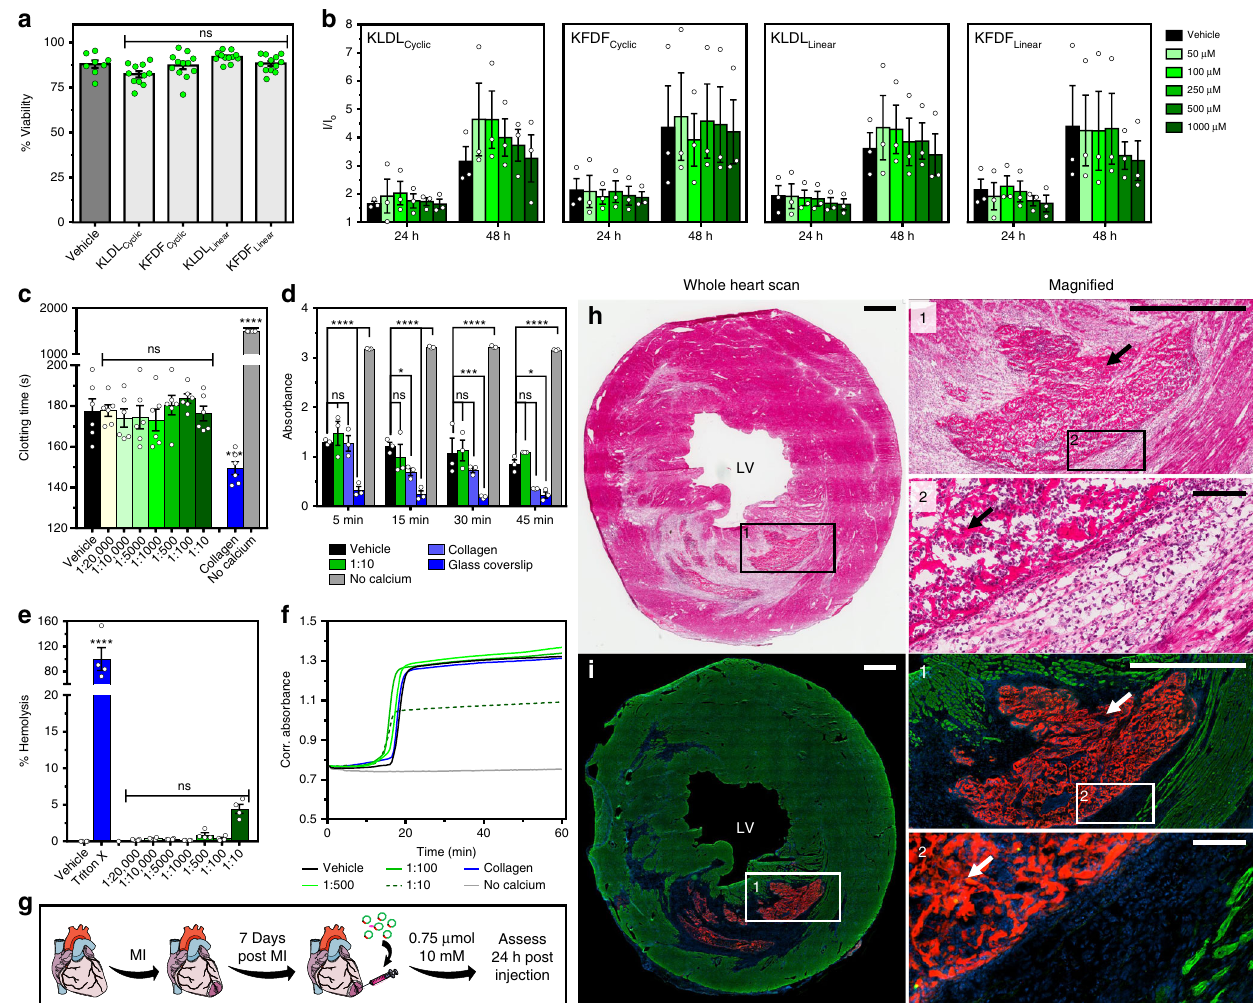
Fig. 8 Cell viability, hemocompatibility, and in vivo analysis. a Acute and b prolonged cytotoxicity of KLDL Cyclic , KFDF Cyclic , KLDL Linear , and KFDF Linear in human cardiac progenitor cells (CPCs). a Percent cell viability after peptide (10 mM) incubation for 4 h ( n = 8 – 12 repeats in duplicate). b Fold increase ( I / I o ) over baseline of CPC viability after incubation for 24 and 48 h with 0, 50, 100, 250, 500, and 1000 µ M peptide ( n = 3 repeats in quadruplicate). c – f Hemocompatibility of progelator (shades of green, 1:20,000, 1:10,000, 1:5000, 1:1000, 1:500, 1:100, and 1:10 blood volume dilution of injected dosage) in human blood with positive (collagen, glass coverslip, and 1% Triton X-100), negative (no calcium), and vehicle (1× Dulbecco's phosphate-buffered saline (DPBS)) controls (blue, gray, and black, respectively). c Activated clotting times (ACT). No calcium controls are >1500 s ( n = 6 per group). d Whole blood hemostasis kinetics at 5, 15, 30, and 45 min (n = 3 per group). e Hemolysis of red blood cells (RBCs) after 1 h of incubation ( n = 4 per group). f Pro- thrombotic pro fi les in platelet-poor plasma (PPP). Onset of coagulation is accompanied by an increase in absorbance ( n = 6 per group). g In vivo study timeline. Female Sprague-Dawley rats received ischemic reperfusion surgery (35 min occlusion), then a single 75 µ L intramyocardial injection (10 mM peptide in 1× DPBS, pH 7.4) of KFDF Cyclic (5 mol% Rho-KFDF Cyclic ) at 7 days post myocardial infarction (MI) to simulate a local injection. Animals were euthanized at 24 h post injection, and hearts were collected ( n = 5 animals). Clipart adapted from Servier ’ s Medical Art database (https://smart.servier. com). h Hematoxylin and eosin (H&E)-stained representative heart section. Inset images illustrate hydrogel assembly in the infarct. Arrows show peptide material. i Corresponding fl uorescence images of the neighboring section, stained for nuclei (blue) and α -actinin (green), with rhodamine-labeled peptide gels in red. LV left ventricle. Scale bars are 1 mm ( h , i , inset 1) and 100 µ m (inset 2), respectively. ns ( p > 0.05), * p ≤ 0.05, *** p ≤ 0.001, and **** p ≤ 0.0001. Ordinary one-way analysis of variance (ANOVA) ( c , e ) and two-way ANOVA ( d ) for comparison with vehicle standard. Values are mean ±